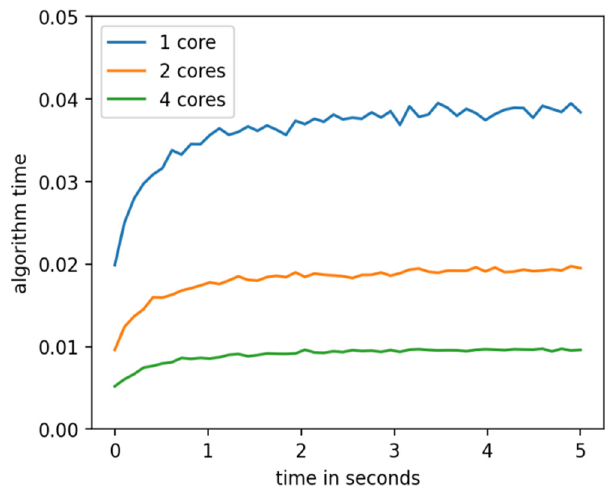
Figure 7. Dependence of algorithm execution time on actual data from the time.